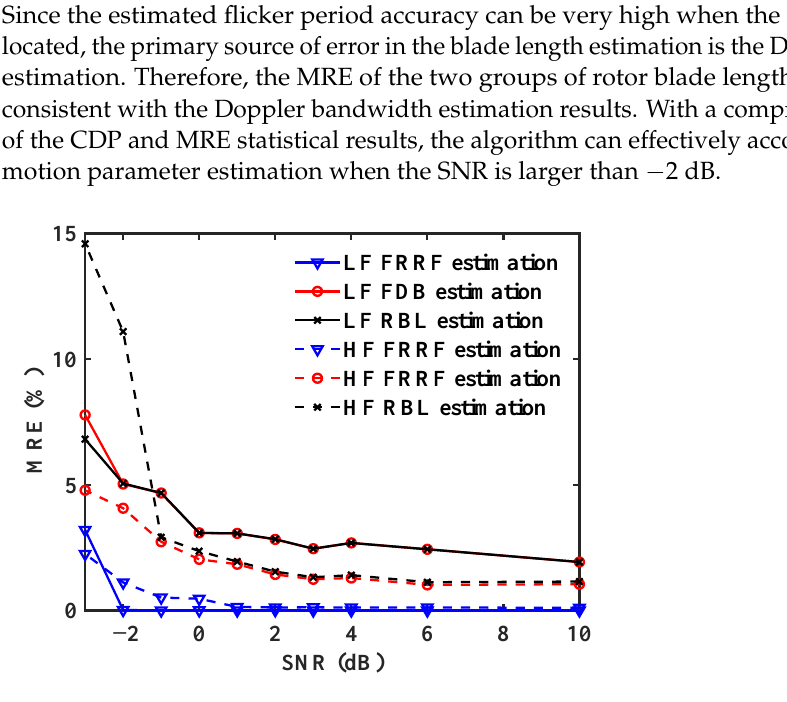
Figure 17. The average relative error of the parameter estimation under a different SNR. FRRF stands for flicker rotor rotating frequency, FDB stands for flicker Doppler bandwidth, and RBL stands for rotor blade